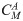
Sensitivity regarding premarital screening rates with respect to educated and uneducated carrier populations.(a) Sensitivity with respect to uneducated and educated carrier single males, CMA and CMAE. (b) Sensitivity with respect to uneducated and educated carrier single females, CFA and CFAE. Note that αsM and αsF are the premarital screening rates for males and females who are about to marry.